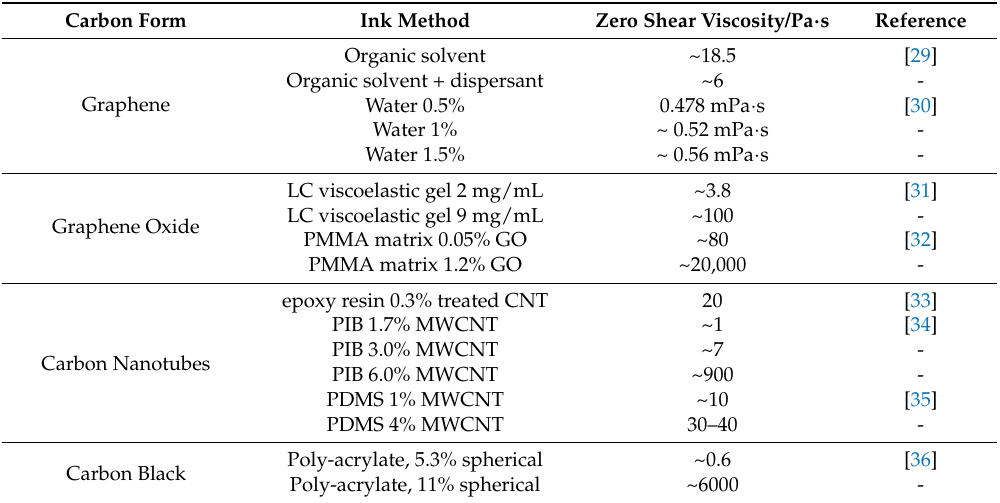
Table 2. Examples from the literature of 3D printable carbon nanoform suspensions (zero shear